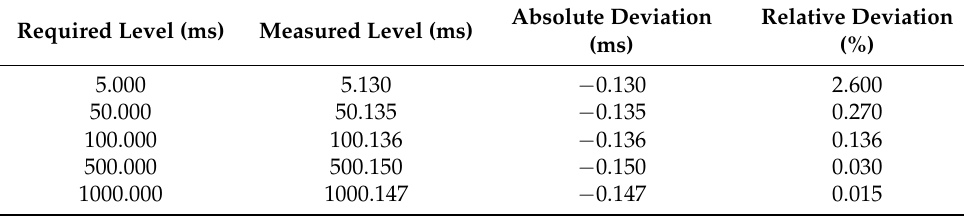
Table 2. Results of measurement of